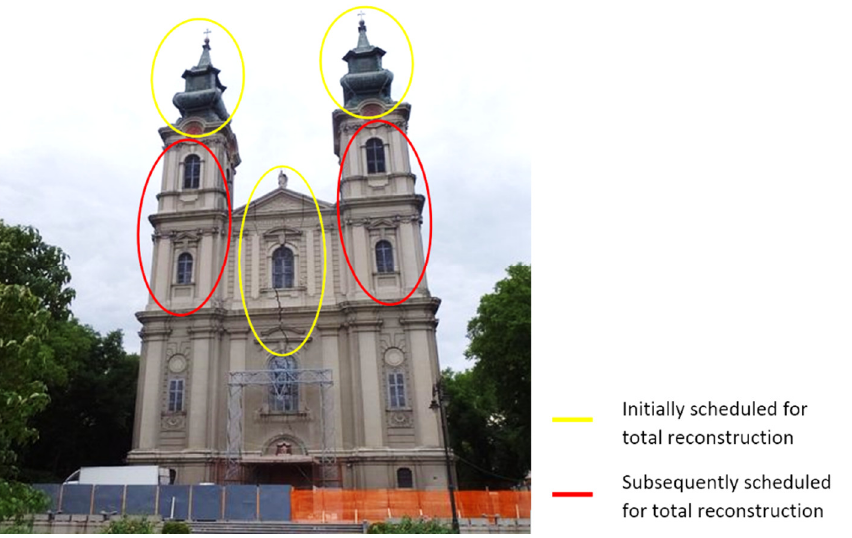
Figure 19. Upper sections of the towers and front façade—proposed total reconstructions